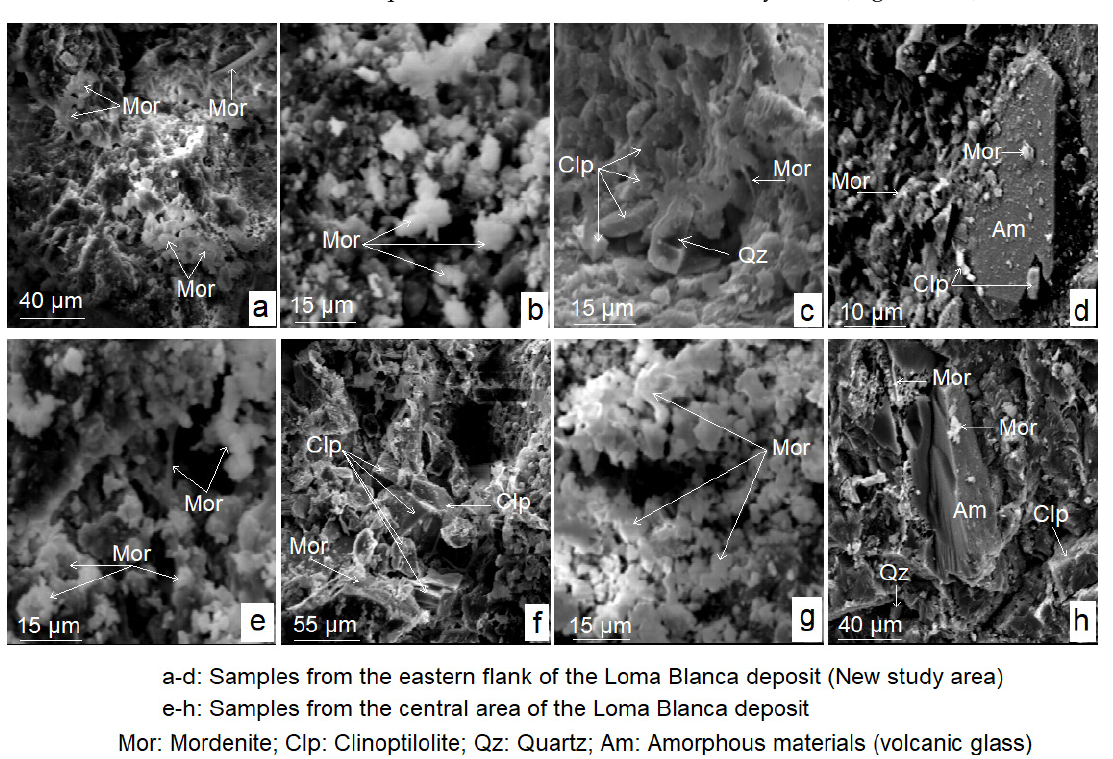
Figure 3. Microphotographs of the samples obtained by SEM. The ( a – d ) series corresponds to the samples from the study area on the eastern flank of the Loma Blanca deposit, whereas the ( e – h ) series are those that come from the central area of this deposit.